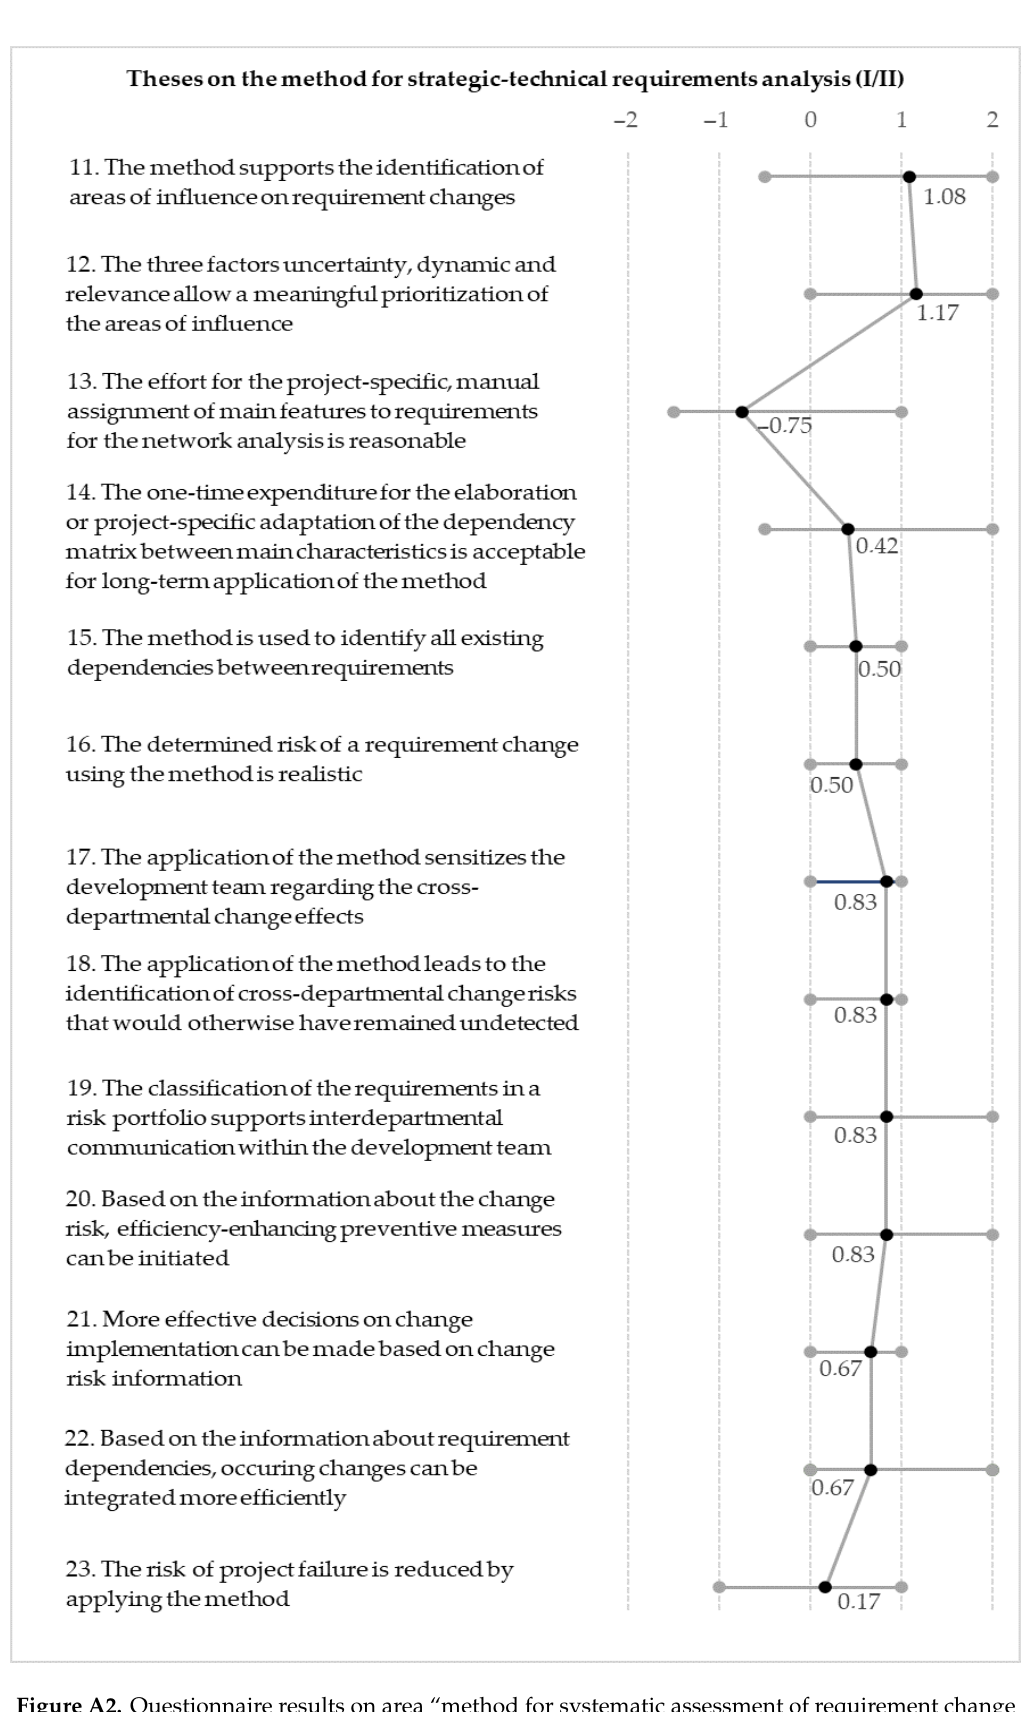
Figure A2. Questionnaire results on area “method for systematic assessment of requirement change risk” – Part I/II.